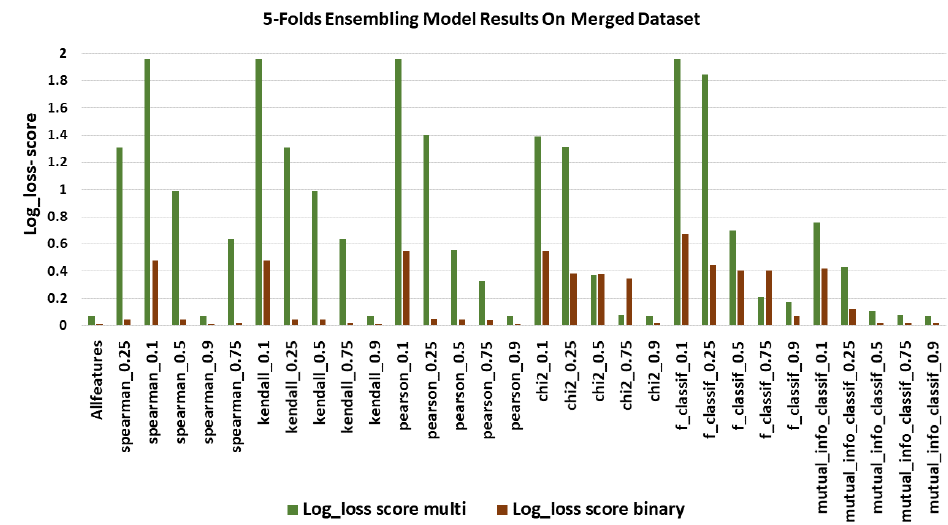
Figure 9. Logloss scores using merged